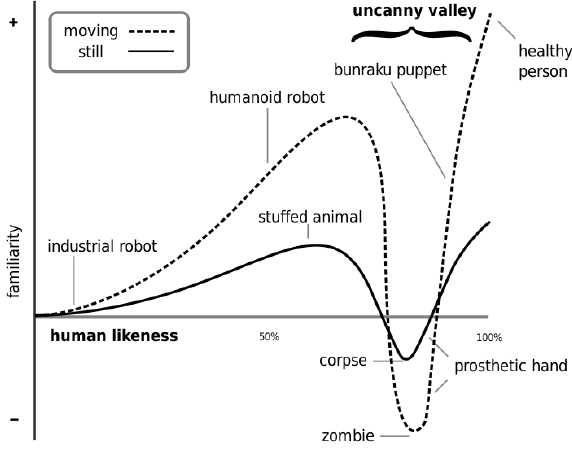
Figure 1. Uncanny valley plot